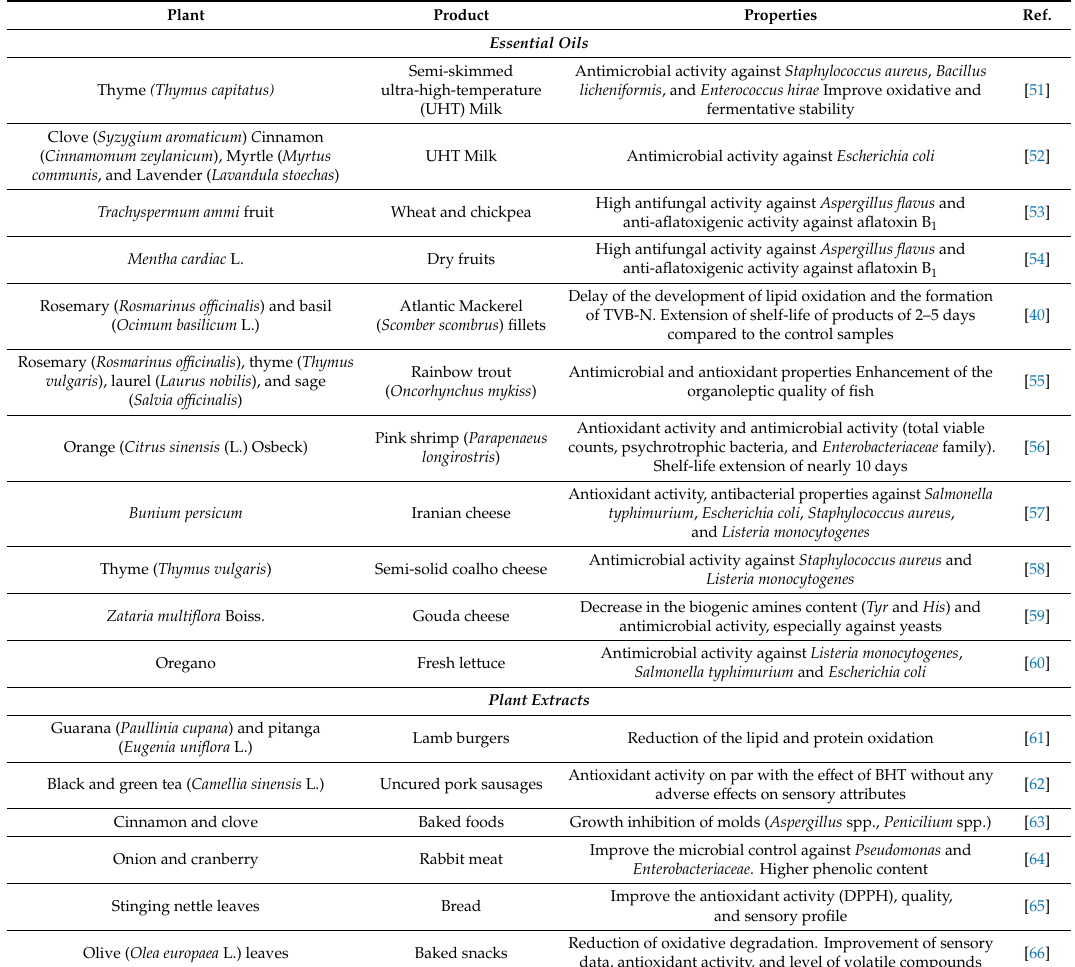
Table 1. Examples of the beneficial properties of adding plant extracts (PE) and essential oils (EO) to di ff erent food